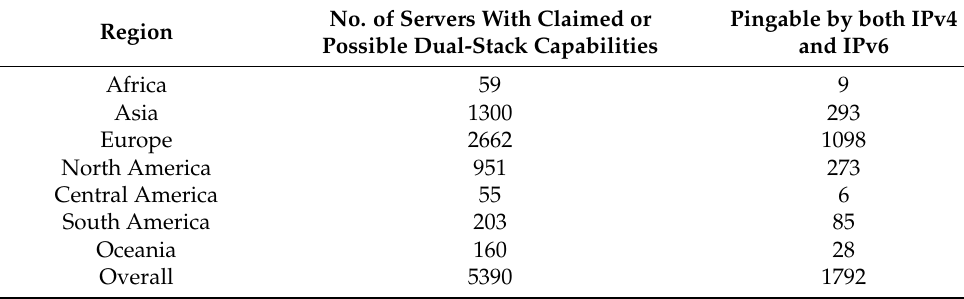
Figure 4. Example of IPv4/IPv6 ping test with batch script. Table 1. The reachable dual-stack sites by